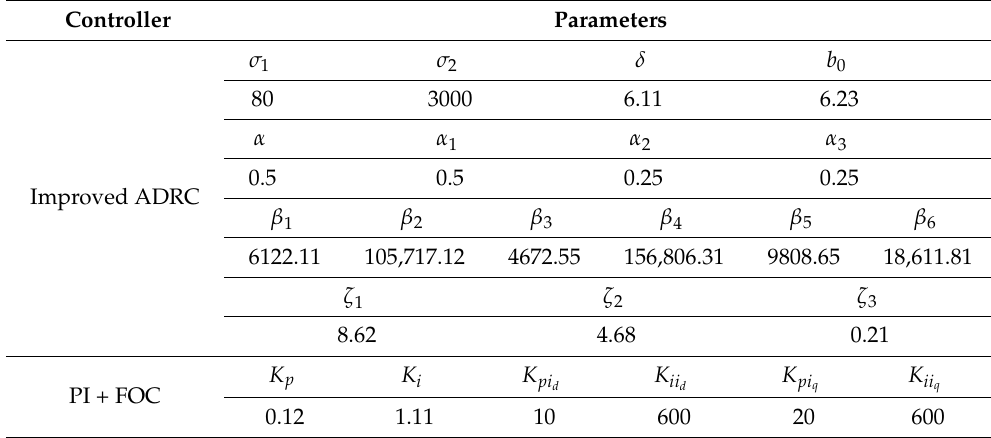
Table 2. The control parameters of the controllers.